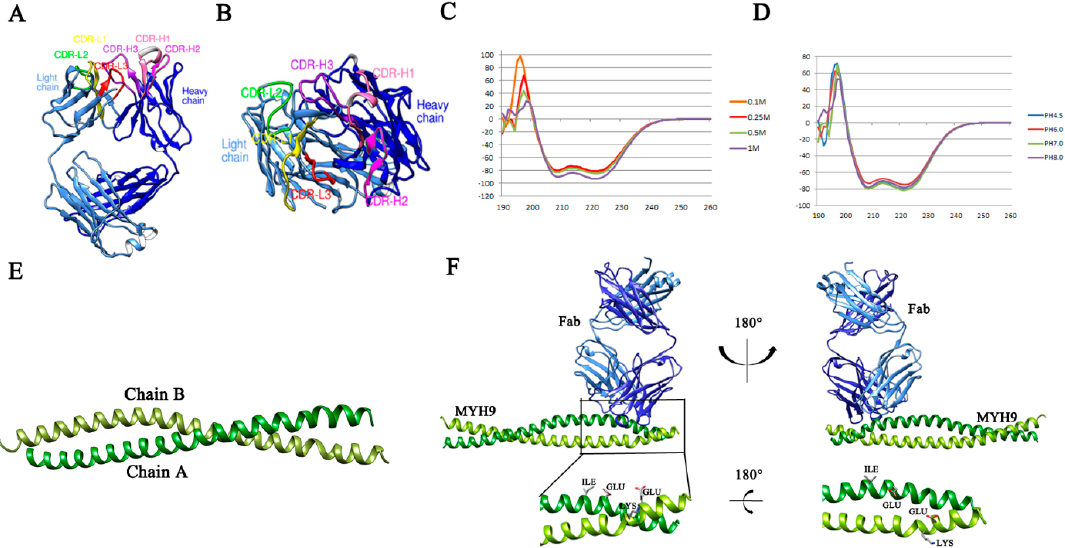
Figure 2. Structural basis of the predicted docking model of Mab2-5G2 Fab with its interacting region of MYH9. ( A ) Diagram showing a representation of the structure of Mab2-5G2 Fab via homology modeling. ( B ) Diagram showing a representation of the structure of Mab2-5G2 Fab via homology modeling of CDRs of Mab2-5G2. ( C ) CD spectra of native PRA protein structures in buffers containing various salt concentrations at pH 7.5. ( D ) CD spectra of native PRA protein structures in buffers with different pH values containing 150 mM NaCl. ( E ) Structure model of PRA domain within MYH9 with two α -chains, chain A shown in green and chain B shown in yellow. ( F ) The structure of predicted docking complex between Mab2-5G2 and its binding interaction region on MYH9.